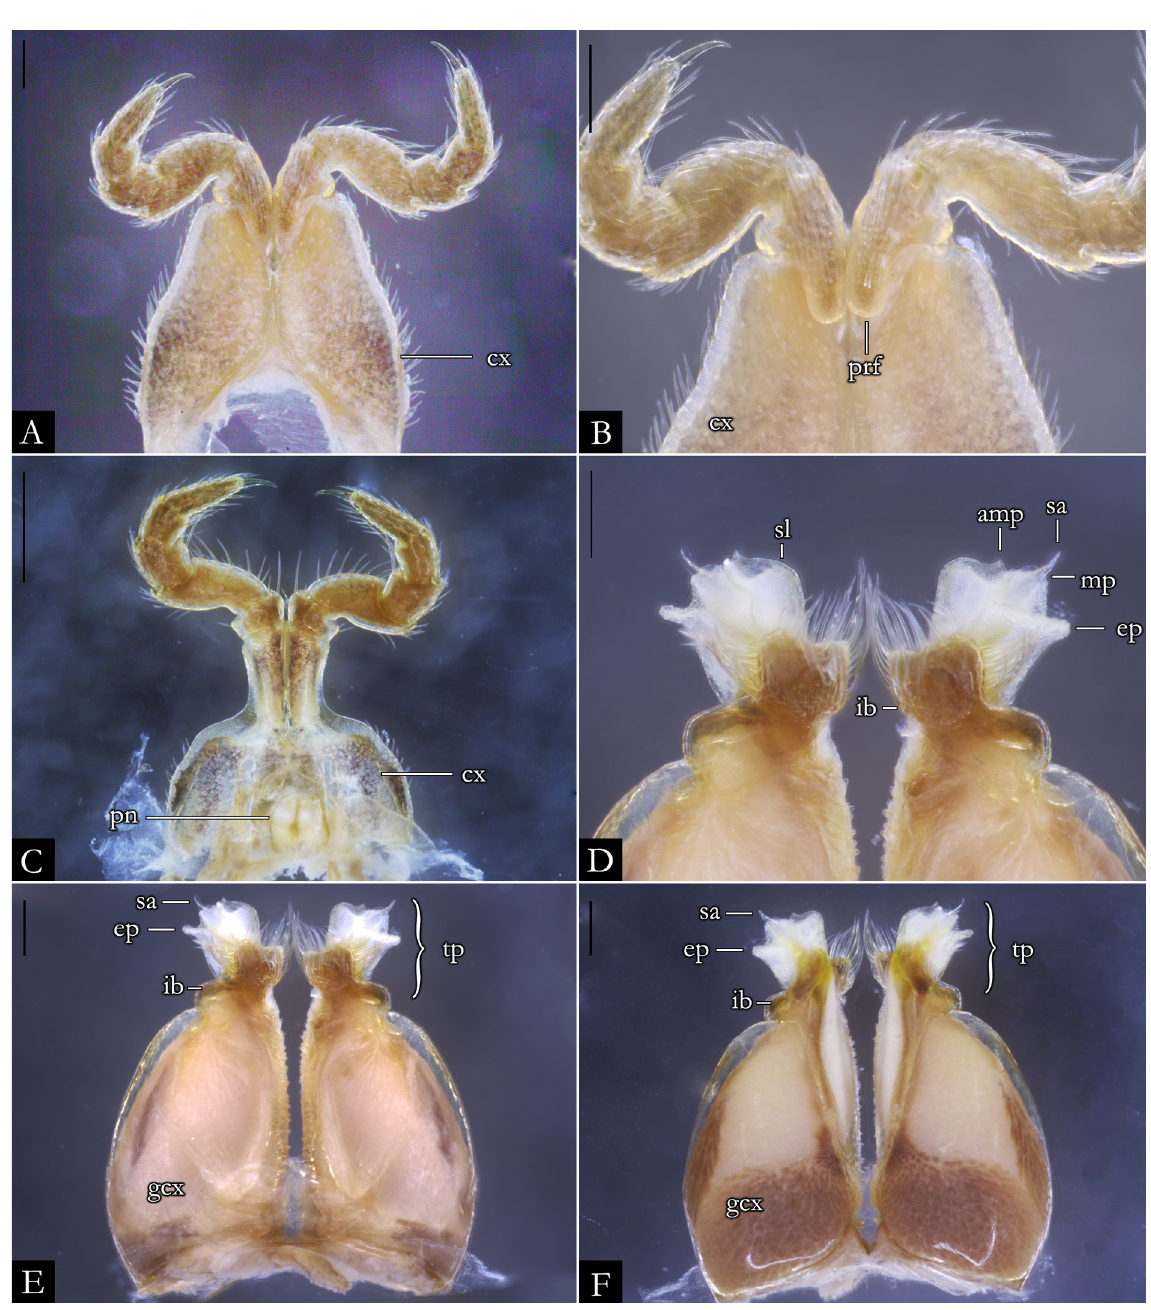
Fig. 160. Pseudonannolene nicolau sp. nov., paratype, ♂ (ABAM). A . First leg-pair. B . Detail of prefemur. C . Second leg-pair. D . Detail of telopodites, in anal view. E . Gonopods, in anal view. F . Gonopods, in oral view. Abbreviations: see Material and methods. Scale bars = 0.2